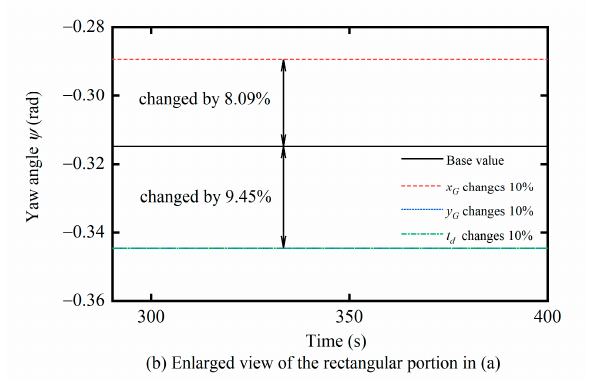
Figure 14. Time evolution of yaw angle with no parameter changes.